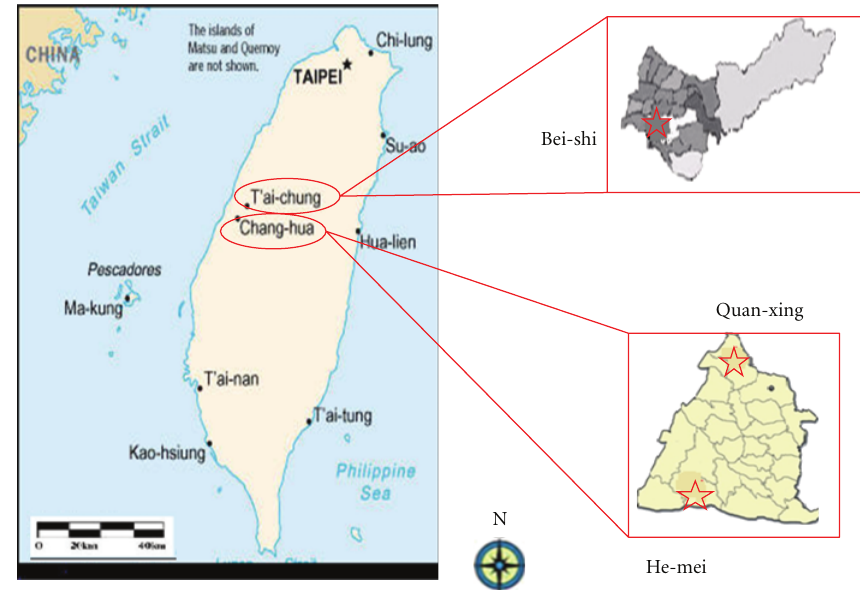
Figure 1: Geographical location for three characteristic sampling sites in central